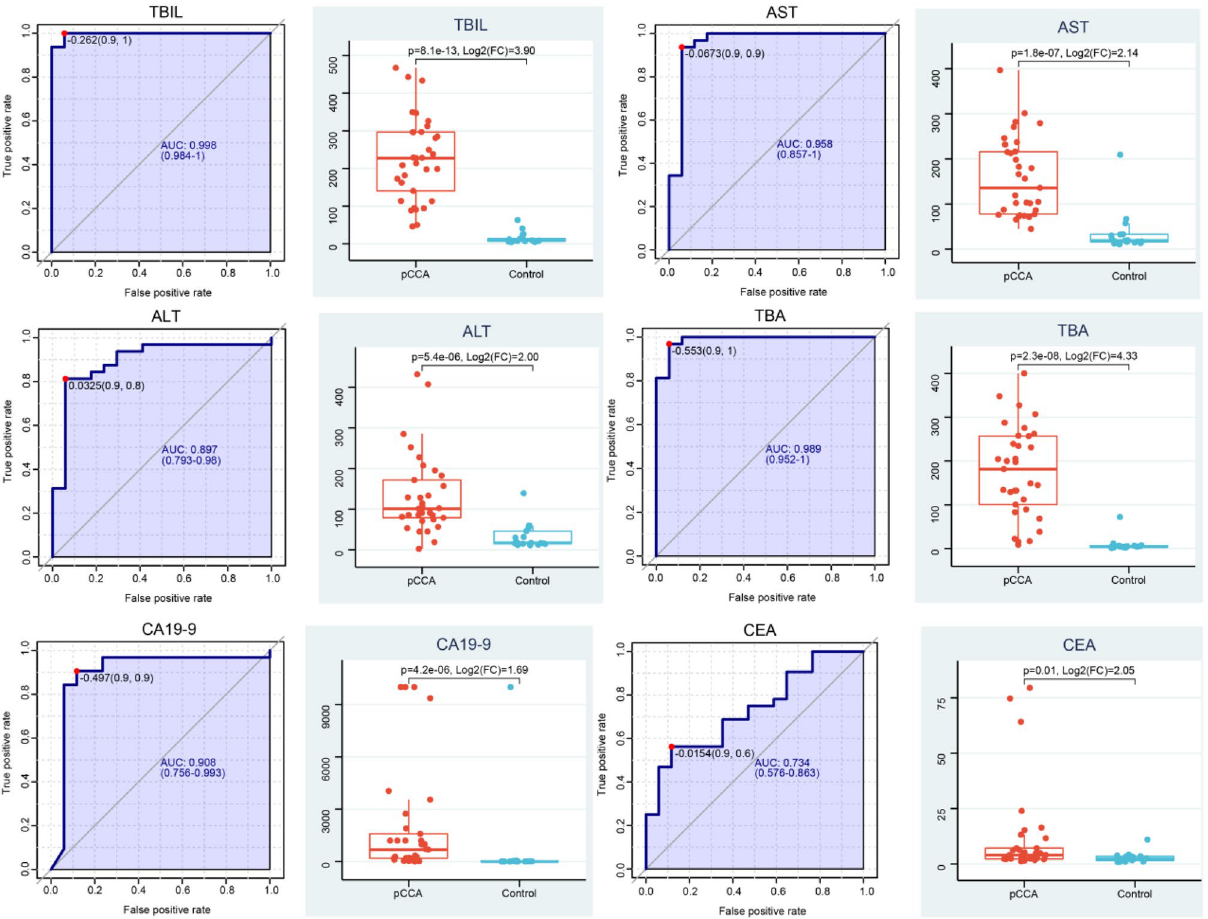
Figure 3. Comparison of clinical indices. There are significant differences in blood TBIL, AST, ALT, TBA, CA19-9,CEA. (p < 0.05, |Log2(pCCA/Control)| ≥ 1). Each point represented one sample. The p < 0.05, |Log2(pCCA/Control)| ≥ 1 indicate significant difference between